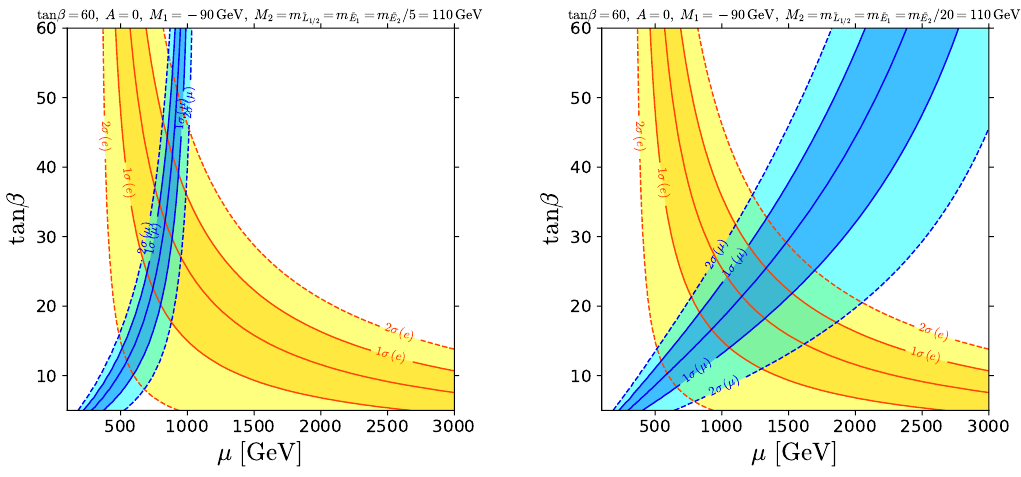
Figure 3 . The same as in (cid:12)gure 2 but in the plane tan (cid:12) vs. (cid:22) for m ~ 110 GeV and M 1 = (cid:0) 90